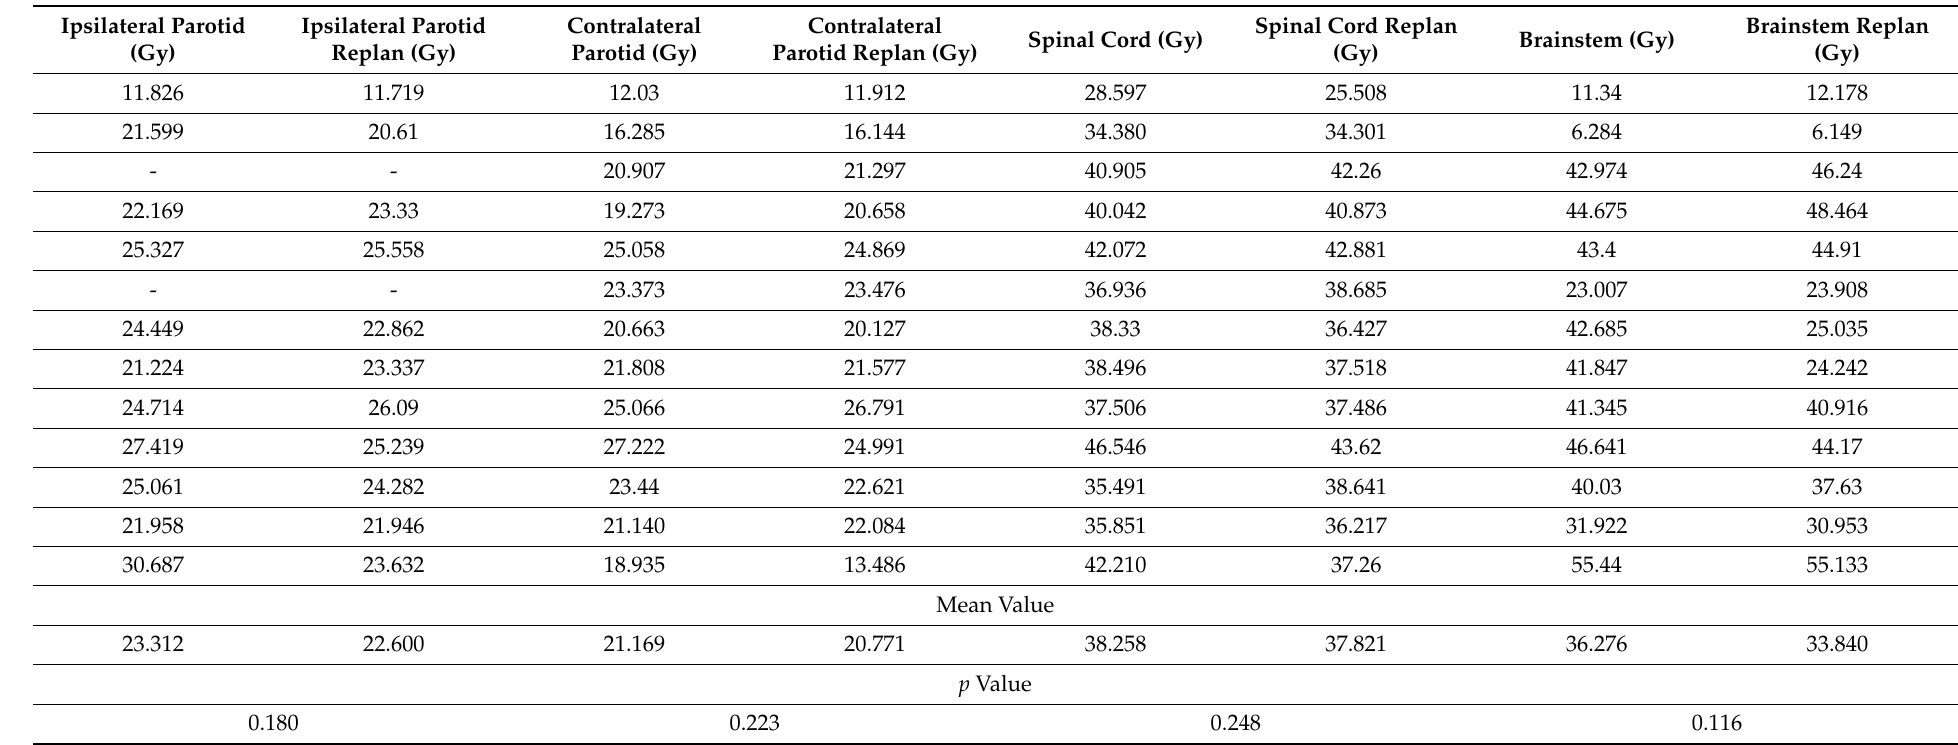
Table 5. Dosimetry of organs at risk before and after